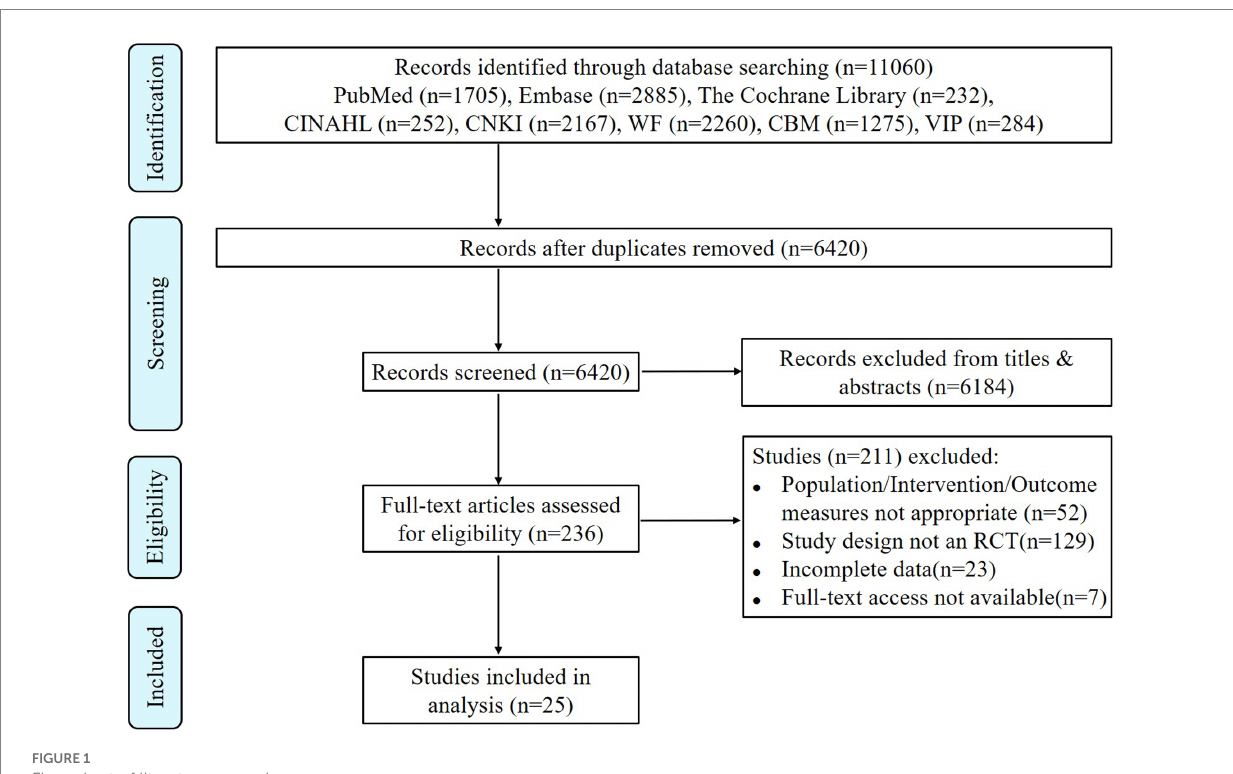
FIGURE 1 Flow chart of literature